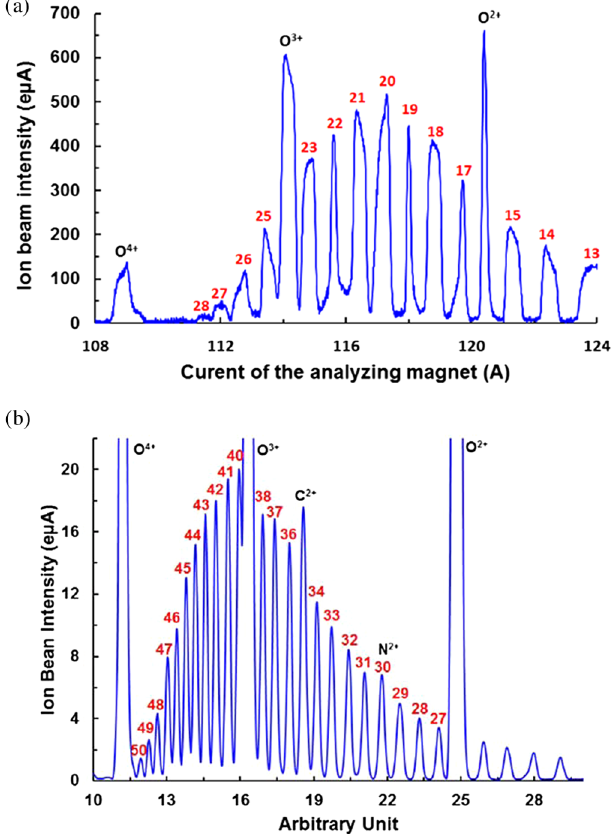
FIG. 12. CSD spectrum with the source optimized for 129 Xe 20 þ and 209 Bi 50 þ . (a) Xenon CSD spectrum with the source optimized for 129 Xe 20 þ at 2.9 kW of 18 GHz microwave power and 25 kV extraction voltage. (b) Bismuth CSD spectrum with the source optimized for 209 Bi 50 þ at 2.6 kW of 18 GHz microwave power and 25 kV extraction